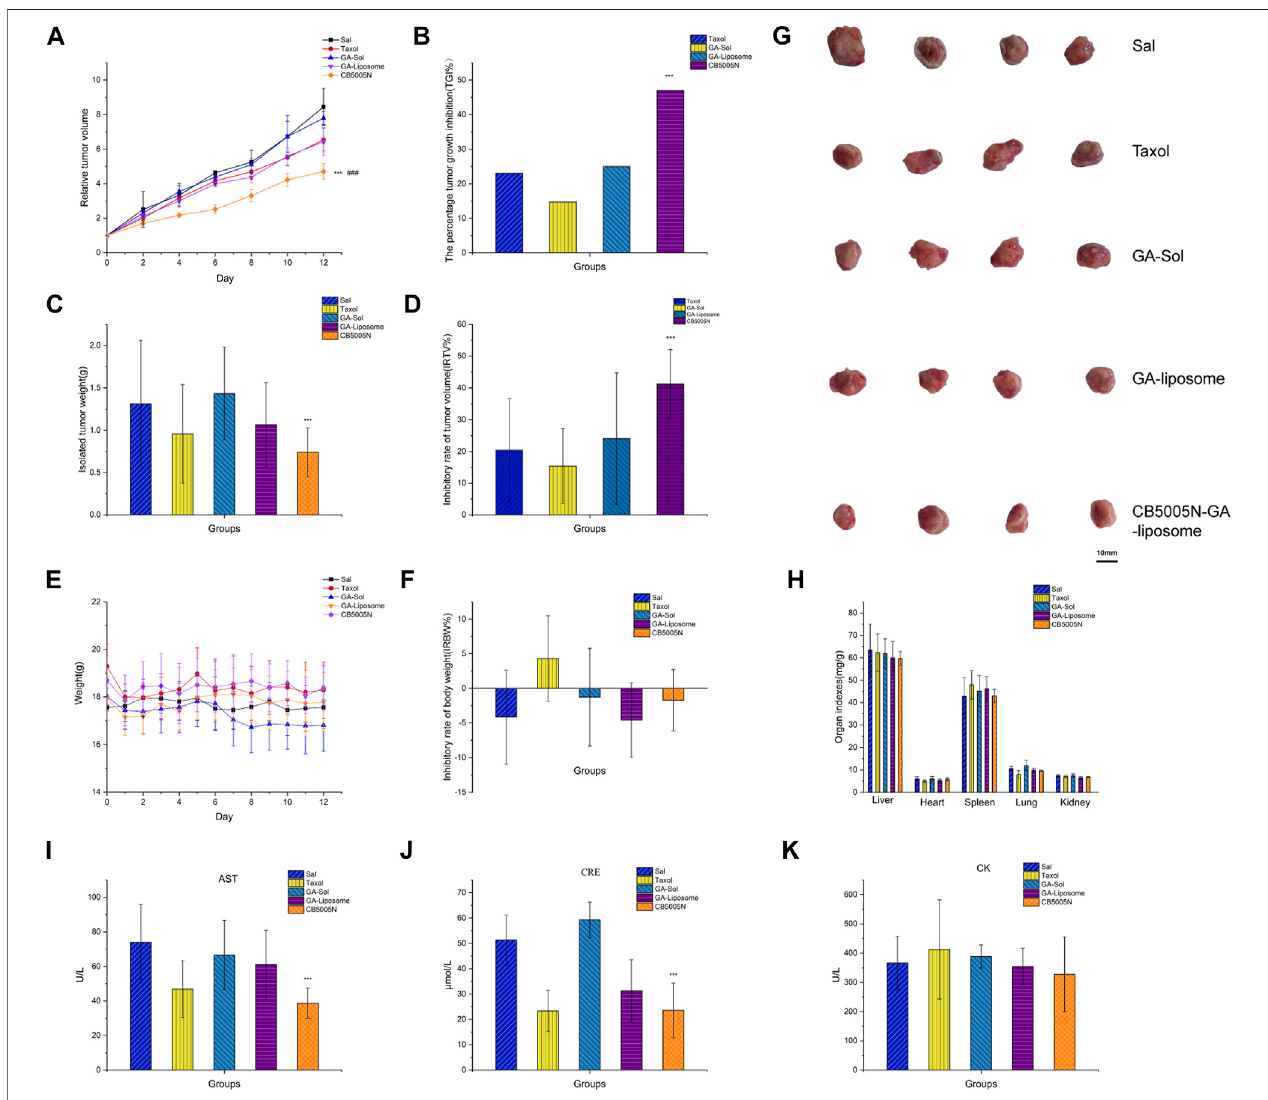
FIGURE 6 | Antitumor effects in vivo . ( (A) Relative tumor volume (B) The percentage tumor growth inhibition (C) Isolated tumor weight (D) Inhibitory rate of tumor volume (E) Weight (F) Inhibitory rate ofbody weight (G) Isolated tumor (H) Thevisceraindex ofmice (I – K) The biochemical markers). Results were expressed asmean ± SD, n = 4 (*** p < 0.001 vs GA-liposome, ### p < 0.001 vs Taxol).